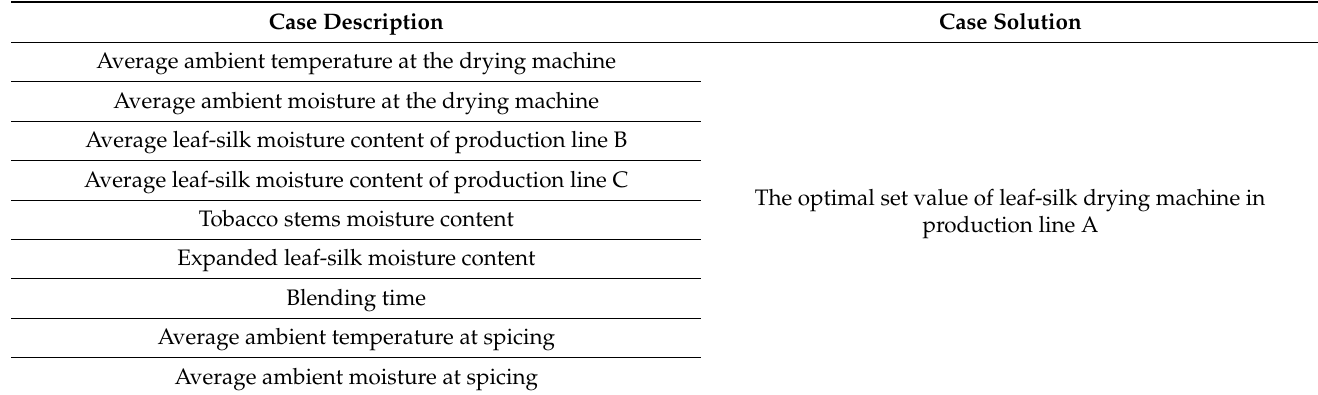
Table 3. Structure of historical case for the operational optimization of cut-made